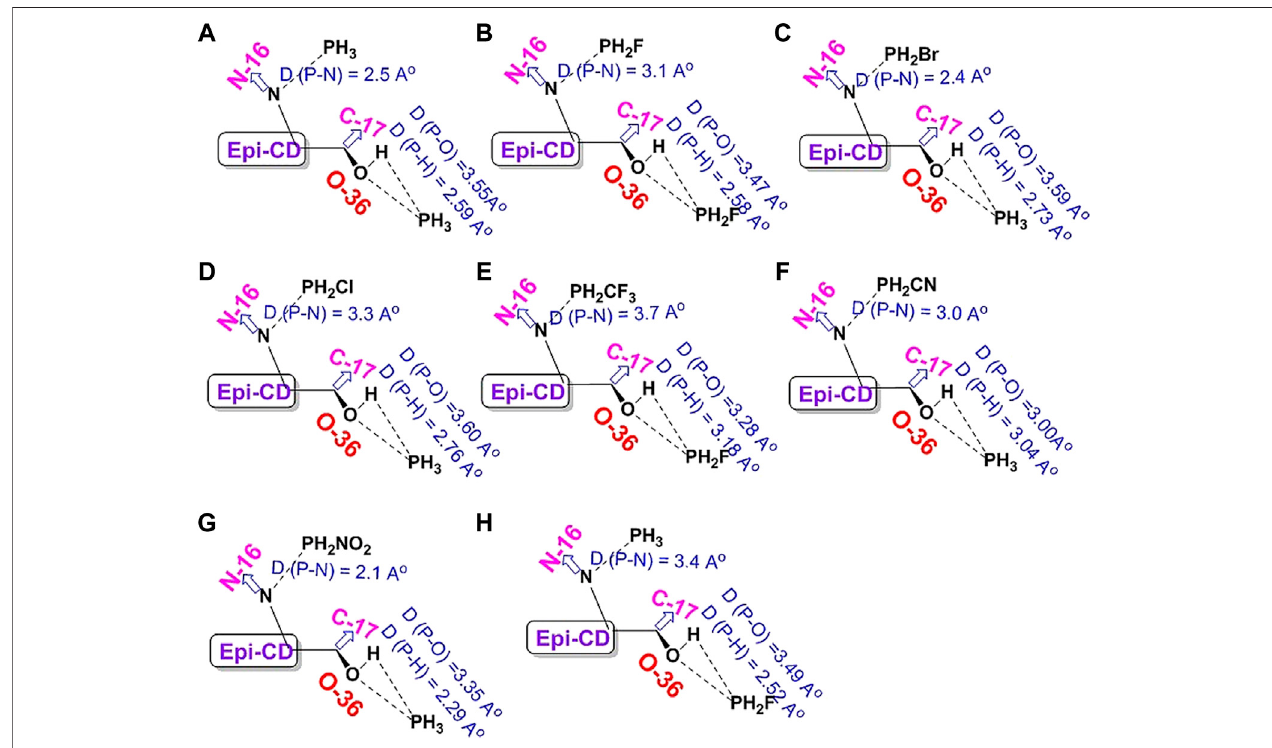
FIGURE 5 | Predicted full UV-Vis spectrum of the epi-cinchonidine complex: X-axis (cid:1) wavelength and Y-axis (cid:1) oscillator strengths and epsilon. Experimental full UV-Vis spectrum of the epi-cinchonidine complex: X-axis (cid:1) wavelength and Y-axis (cid:1) observance.